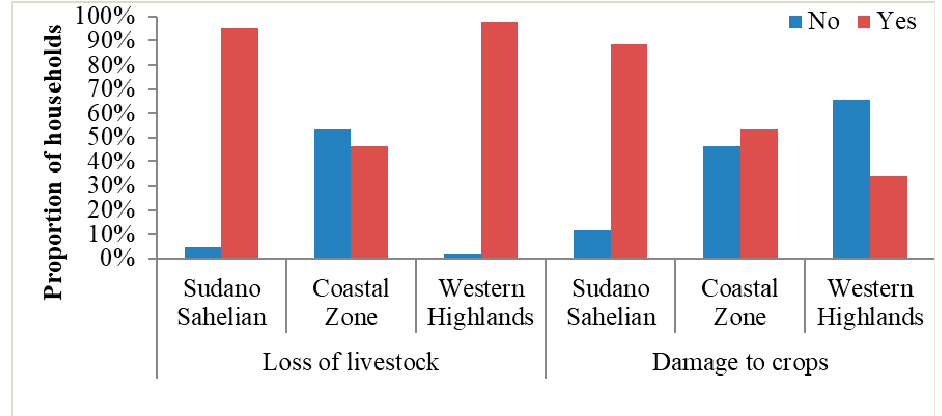
Figure 5. Loss of and damage to household productive assets, share of households. Notes: Chi-square livestock = 622.77, p = 0.000; Chi-square crop = 537.676, p = 0.000.